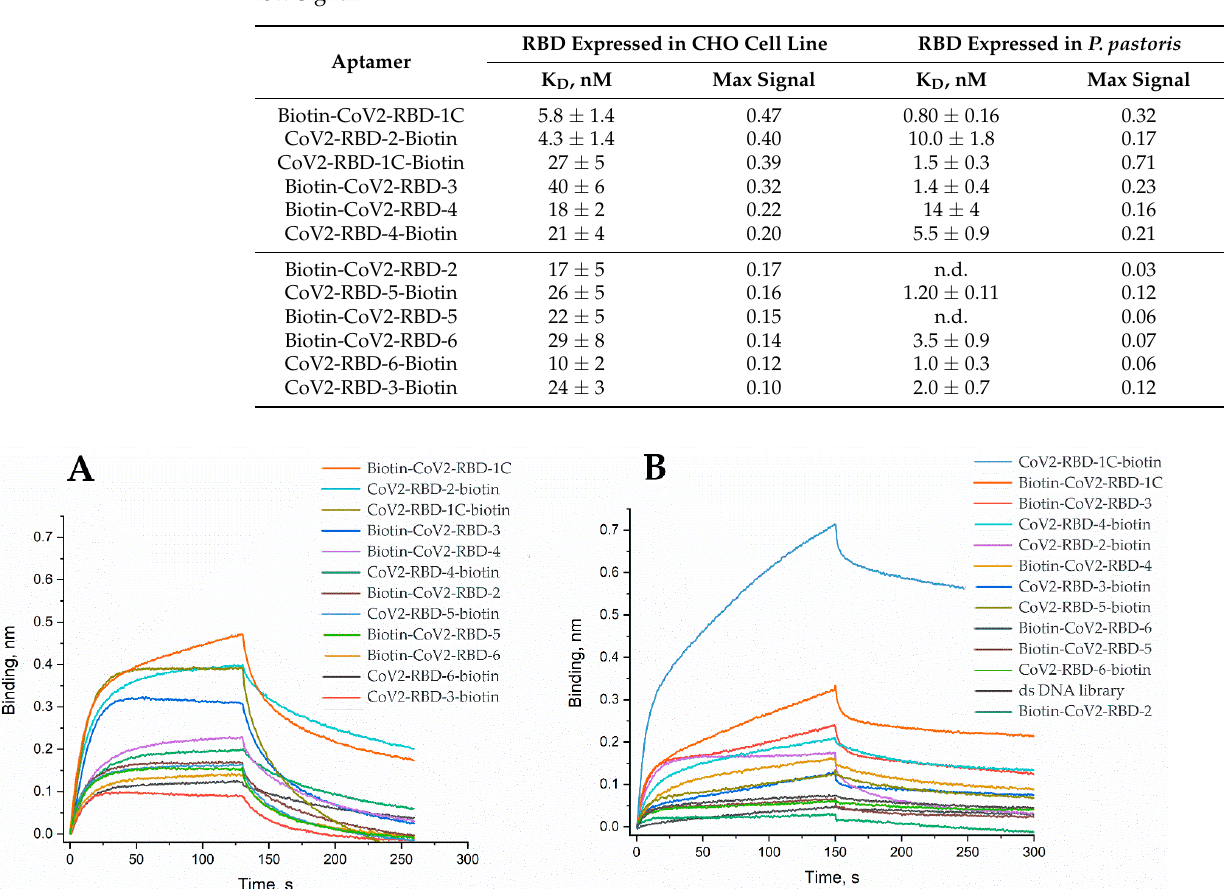
Table 1. Estimated dissociation constants for aptamer-RBD complexes and maximal signal of the binding curves in 100 nM solution of RBD protein. Aptamers are ranged according to maximal signal of the binding curves for RBD protein expressed in CHO cell line. n.d.—not determinable due to low signal.